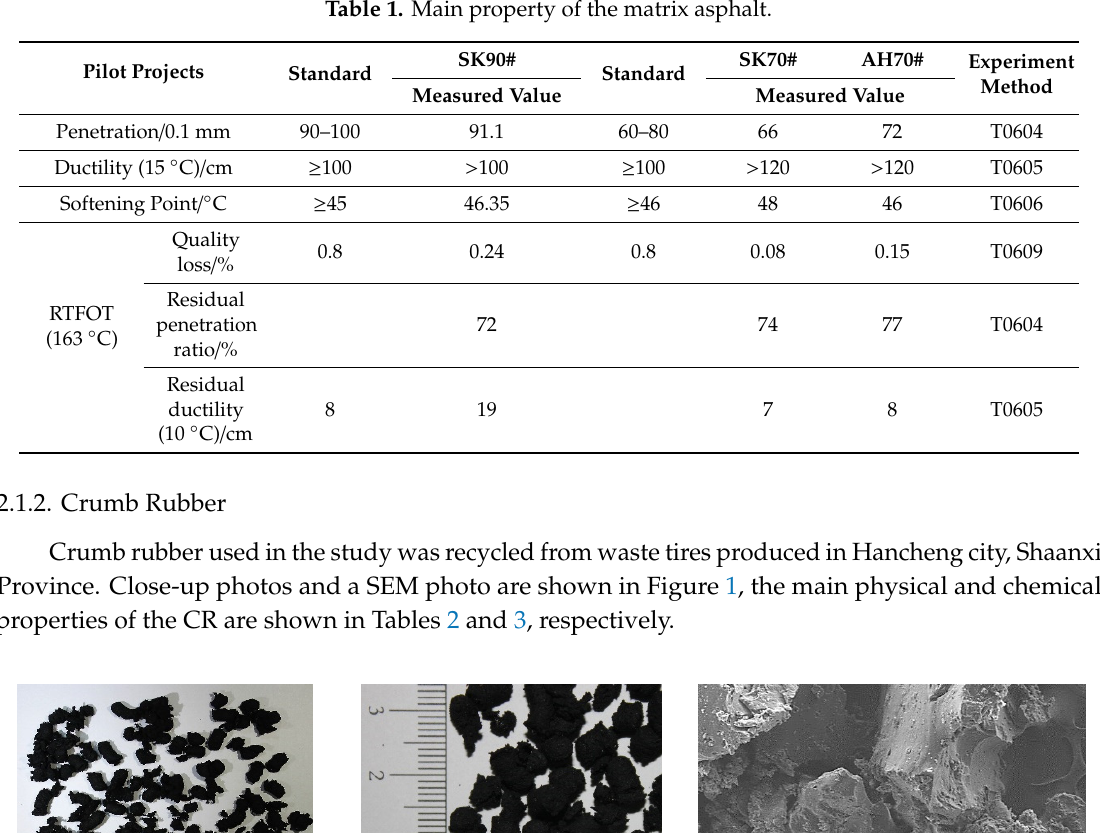
Table 1. Main property of the matrix asphalt.